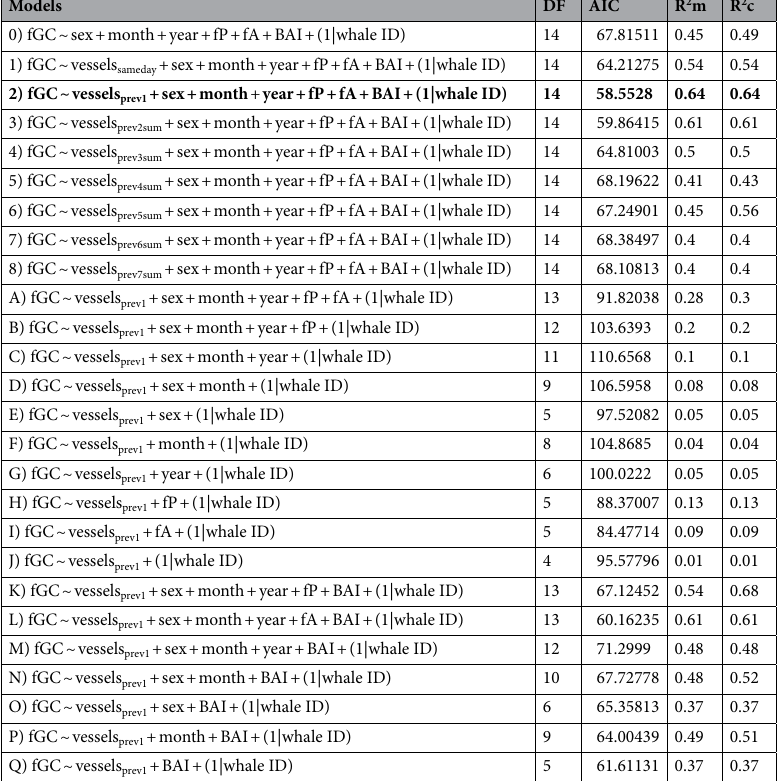
Table 1. Linear mixed model (LMM) selection parameters of gray whale fecal glucocorticoid metabolite (fGC) concentrations relative to vessel counts, sex, year, progestin metabolites (fP), androgen metabolites (fA) and body condition (Body Area Index: BAI). All models used whale identification (whale ID) as a random factor to account for pseudoreplication. Models 1–8 included the same predictor variables except vessel counts, which was assessed at different temporal scales in each model and ranged from the count of vessels on the same day of the fecal sample collection (vessels sameday , model 1) to the count of vessel within the seven previous days (vessels prev7sum , model 8). Model zero is the null model, which does not include vessels. Once the most influential temporal scale for vessel counts was determined (i.e., previous day; Model 2), 17 additional LMMs were run with varied combinations of the fixed effects (stepwise process, models A-Q; below the thin black line). Model in bold represents the selected model based on the lowest Akaike Information Criterion (AIC). The degrees of freedom for each model are indicated by DF. The fit of each model is represented by the marginal R 2 (R 2 m; variance explained by fixed effects) and the conditional R 2 (R 2 c; variance explained by both fixed and random